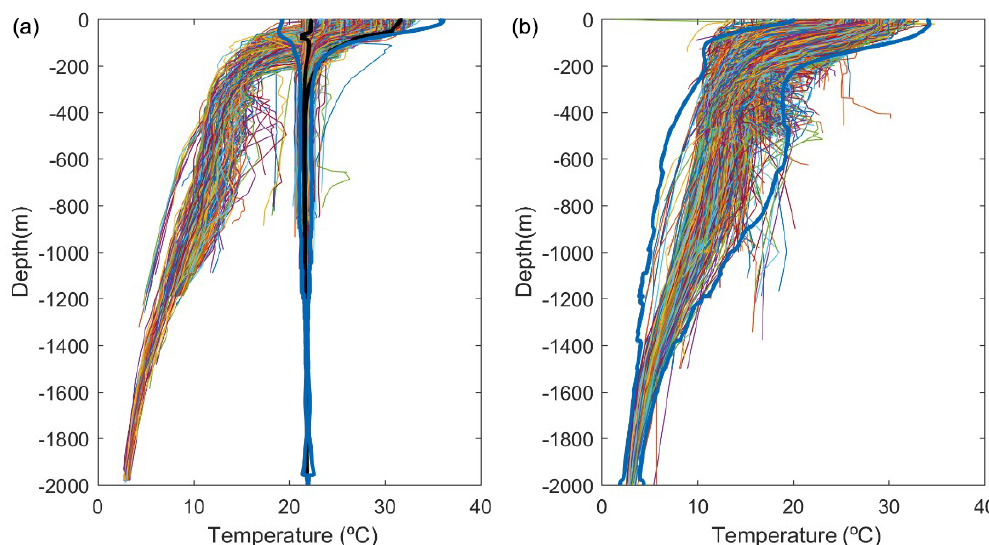
Figure 2. CORA profiles inside the Red Sea (a) and in the outer region (b) . The 1st and 99th quantiles of the KAUST profiles are shown in black. The range defined by 3 times the SD of the CORA profiles is shown in blue.